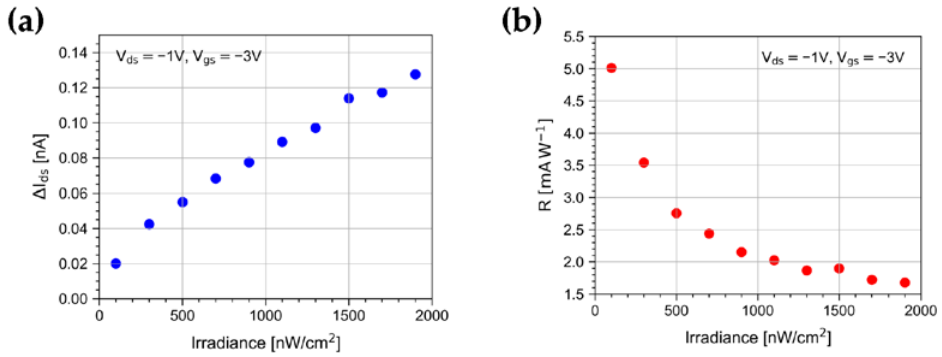
Figure 9. Trend of ( a ) ΔI ds and ( b ) R for 10 s light pulses as a function of the irradiance at V gs = − 3 V and V ds = − 1